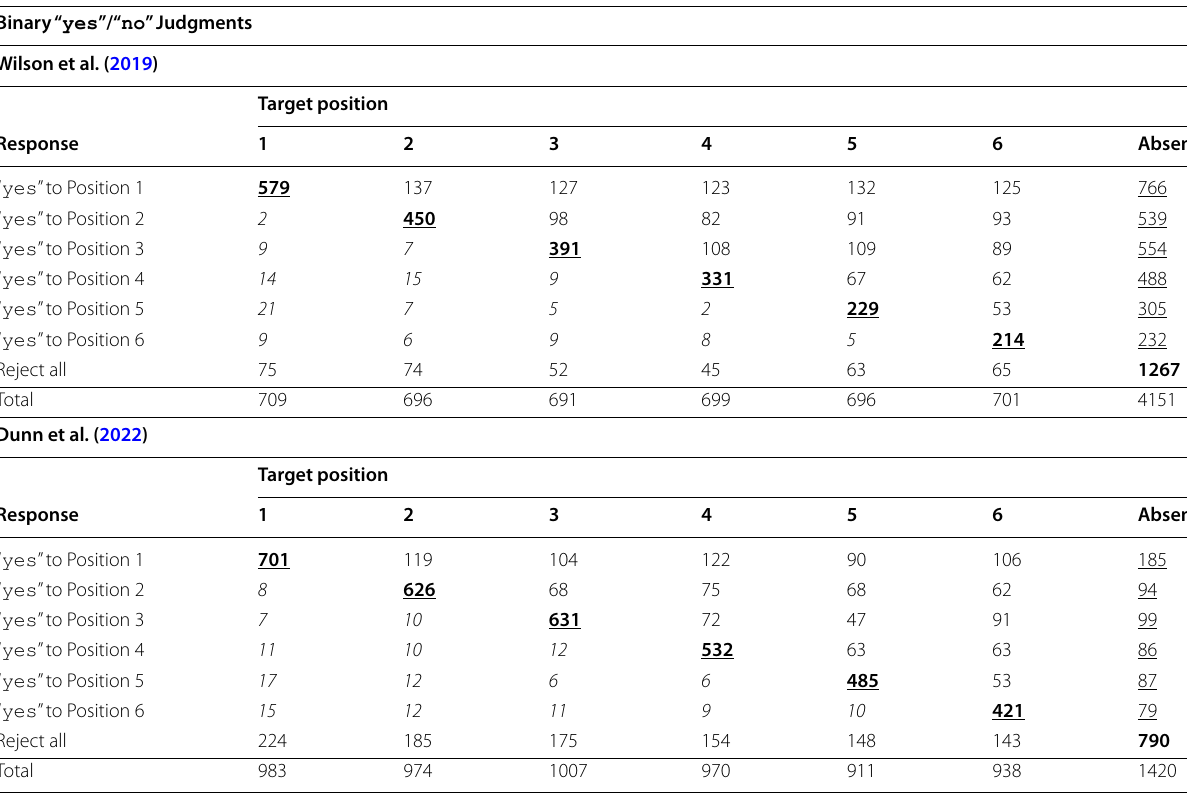
Table 1 Choice frequencies from Experiments 1 and 2 of Wilson et al. (2019) and Dunn et al. (2022)